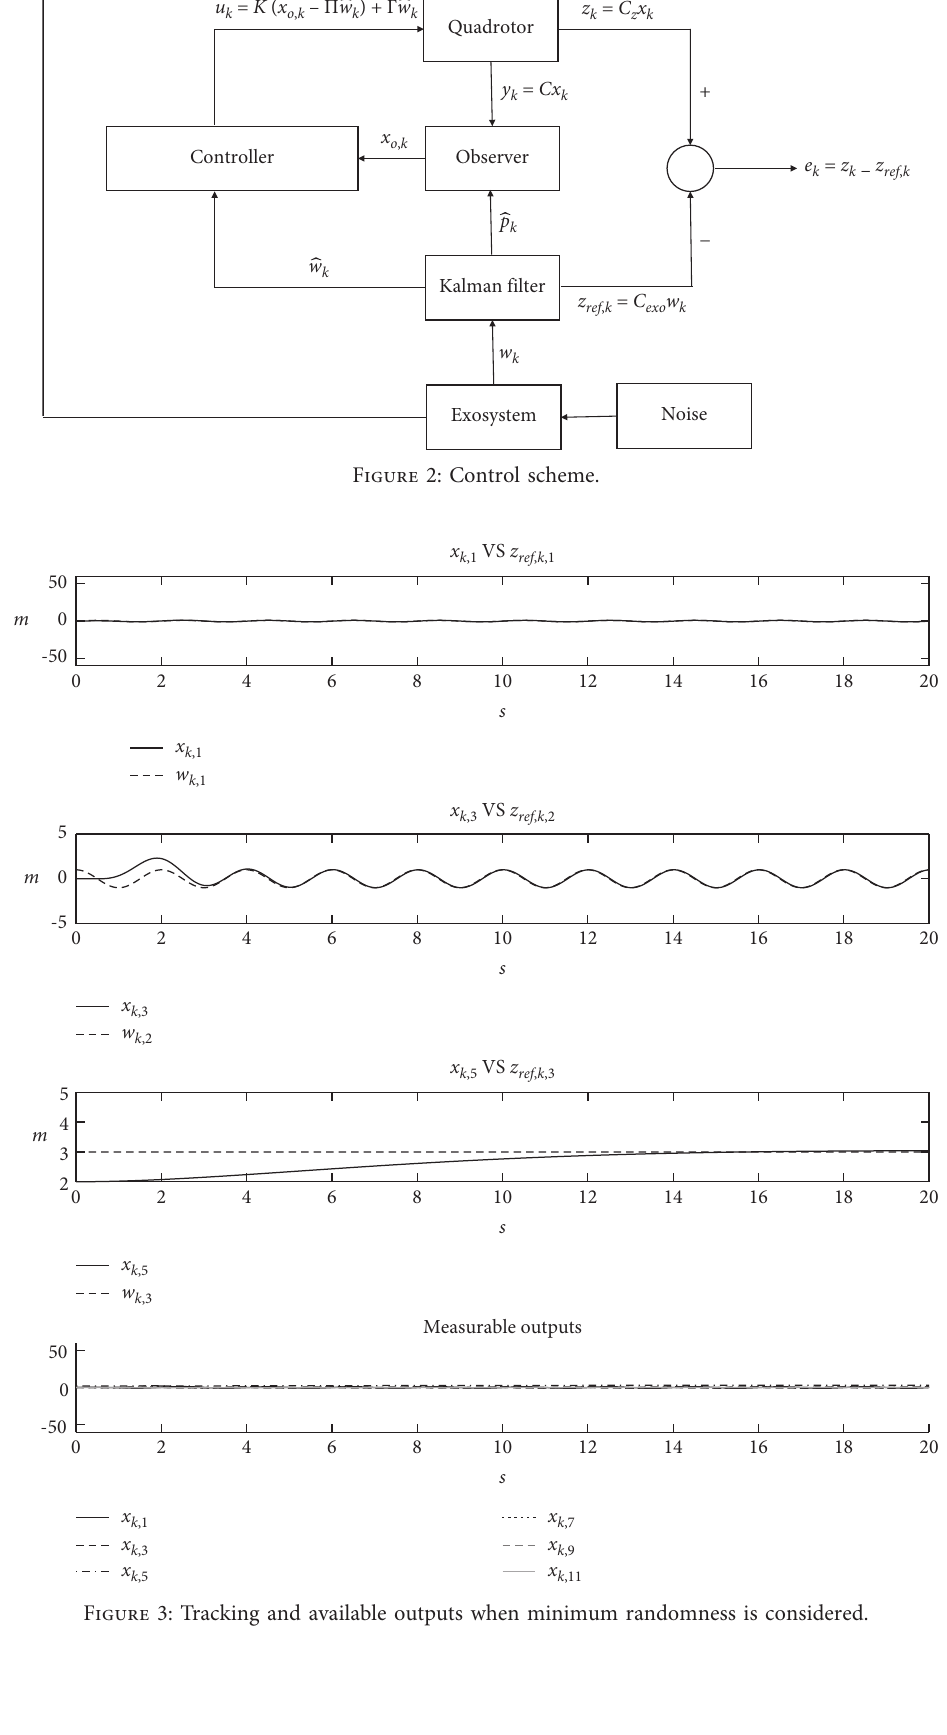
Figure 3: Tracking and available outputs when minimum randomness is